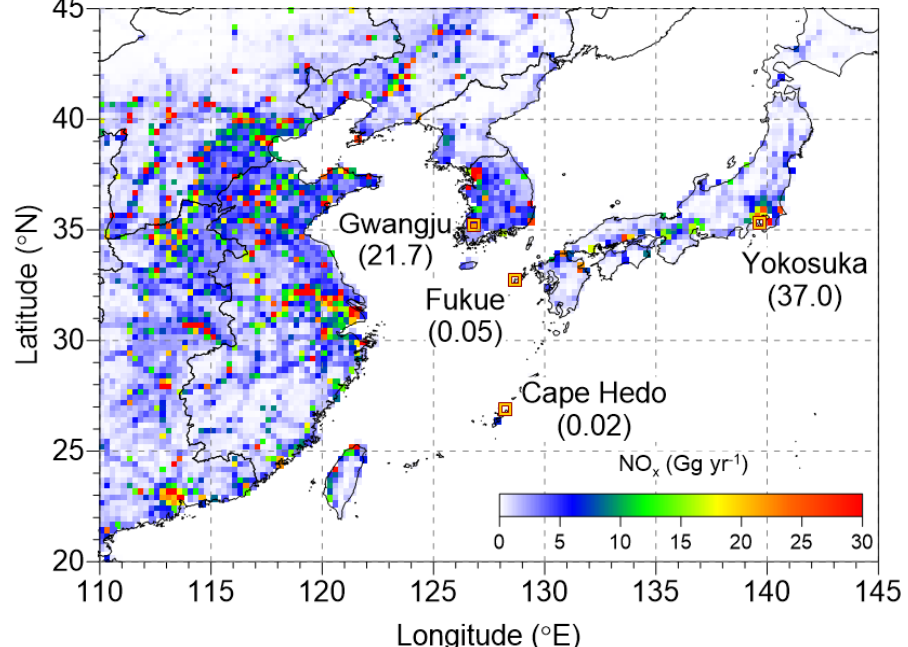
Figure 1. Emission rates of NOx (Gg yr −1 ) in the Regional Emission inventory in ASia (REAS) version 3.2 [12] over East Asia and site locations of selected MAX-DOAS networks (Gwangju in Korea and Yokosuka, Fukue, and Cape Hedo in Japan). The numbers in parentheses indicate the NOx emission rate of each site.